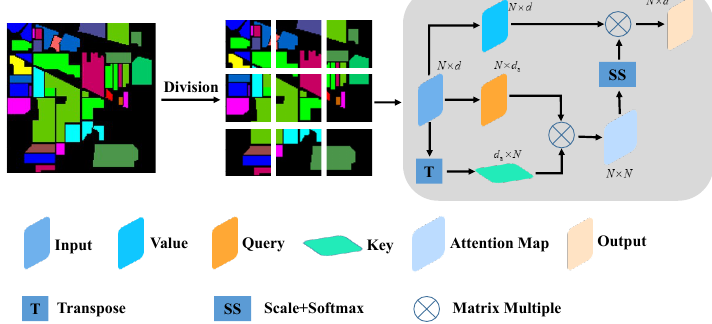
Figure 2. Structure of the self-attention mechanism.